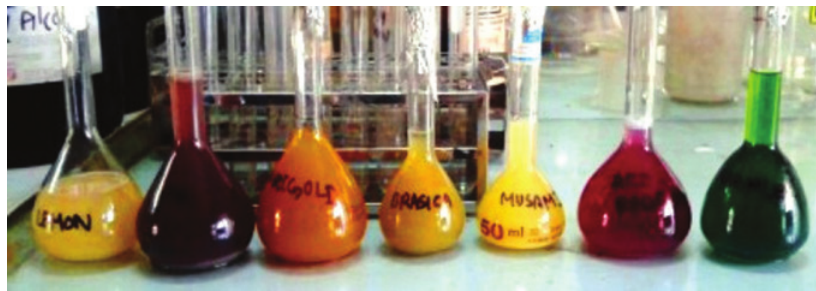
Figure 3: Extracted crude dyes from various sources.